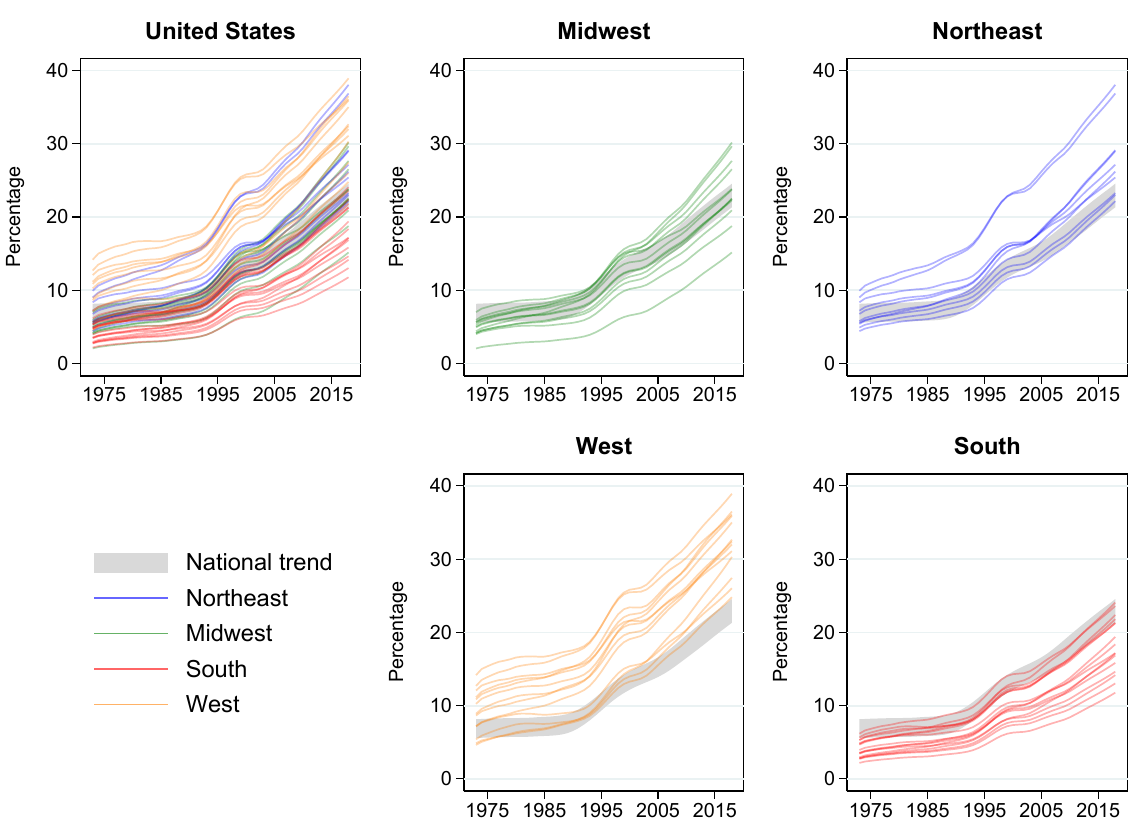
Figure 3: State-level trends in the share of religious nones based on Dynamic MRP, 1973 to 2018. Notes: The state-level trends have been smoothed using locally weighted regressions with a bandwidth of 0.2. The national trend has been smoothed using a locally weighted regression with a bandwidth of 0.4 and is plotted using the 95 percent confidence intervals around this smoothed trend. An interactive version of this figure is available at https://dingemanwiertz.github.io/nonesFig3/